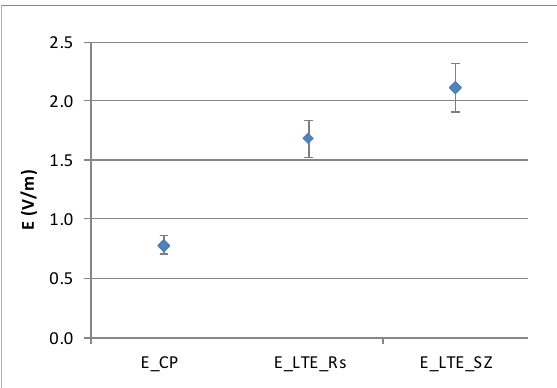
Figure 8. Comparison between the final results of the three modalities.